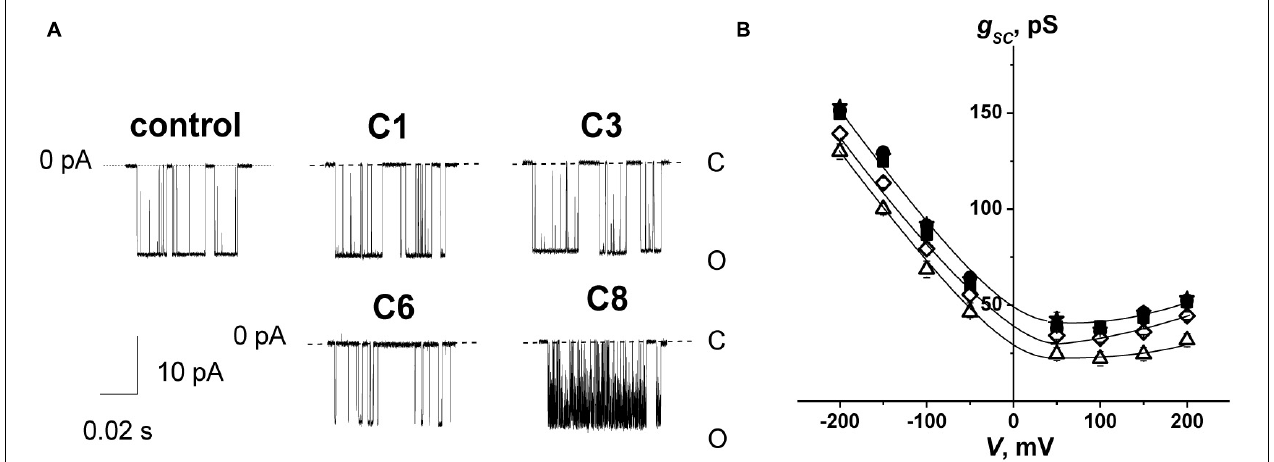
FIGURE 2 | (A) Current fluctuations corresponding to the openings and closings of single SyrE channels in the absence ( control ) and presence of 100 µ M of C1, C3, C6, and C8. V = –200 mV. C , closed state of the channel, and O , open state of the pore. (B) G ( V ) curves of single SyrE channels in the absence ( (cid:4) ) and presence of 100 µ M of C1 ( (cid:4) ), C3 ( • ), C6 ( (cid:49) ), and C8 ( ♦ ). The membranes were composed of DPhPC and bathed in 2.0 M KCl at pH 7.4. TABLE 3 | Effects of 1,3-thiazine, 1,2,3,4-dithiadiazole, and thiohydrazide derivatives on the ion-permeable pores induced by the different antifungals SyrE, Fen, and Nys. Compound Antifungal pore-forming agent SyrE* Nys & Fen # g sc , pS τ , ms P op I ∞ /I ∞ 0 I ∞ /I ∞ 0